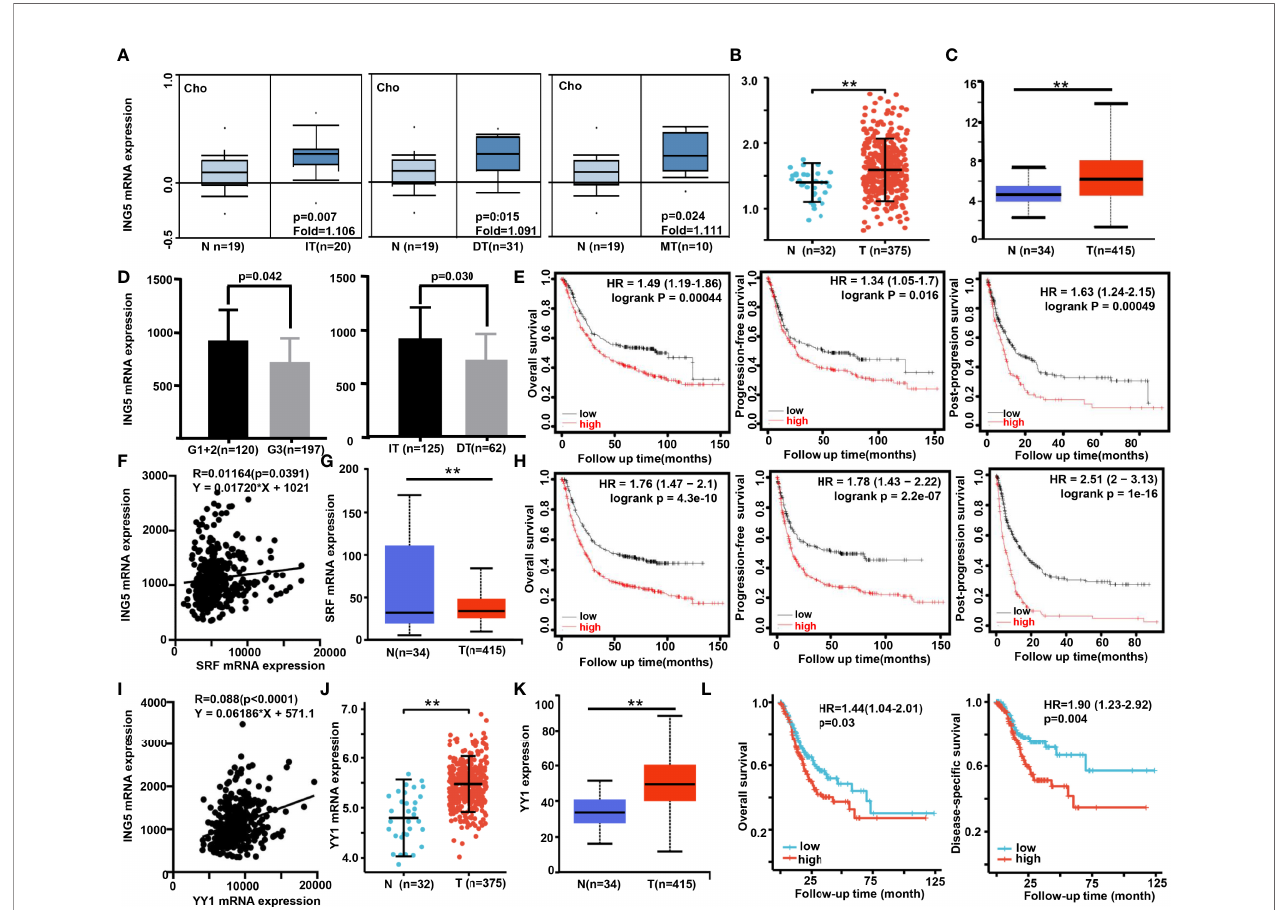
FIGURE 3 | The clinicopathological signi fi cance of ING5 , SRF and YY1 mRNA expression in gastric cancer Oncomine (A) , Xiantao (B) , and/or UALCAN (C) datasets were employed to analyze ING5 mRNA expression in gastric cancer, and the correlations of its expression with pathological parameters of cancers were analyzed using TCGA (D) . Kaplan – Meier curves were used to analyze the relationships of ING5 mRNA expression with overall (OS), progression-free (PFS), and post- progression (PPS) survival, according to Kaplan-Meier plotter (E) . The relationship between SFR and ING5 mRNA expression was analyzed using TCGA data (F) . SRF mRNA expression was explored in gastric cancer using UALCAN (G) . The prognostic signi fi cance of SRF mRNA expression was investigated using Kaplan- Meier plotter (H) . We also investigated the relationship between YY1 and ING5 mRNA expression using TCGA data (I) . YY1 mRNA expression was explored in gastric cancer using Xiantao (J) and UALCAN (K) . The prognostic signi fi cance of SRF mRNA expression was studied using Xiantao platform (L) . N, normal mucosa; T, tumor; IT, intestinal type; DT, diffuse type; MT, mixed-type; HR, hazard ratio. ;